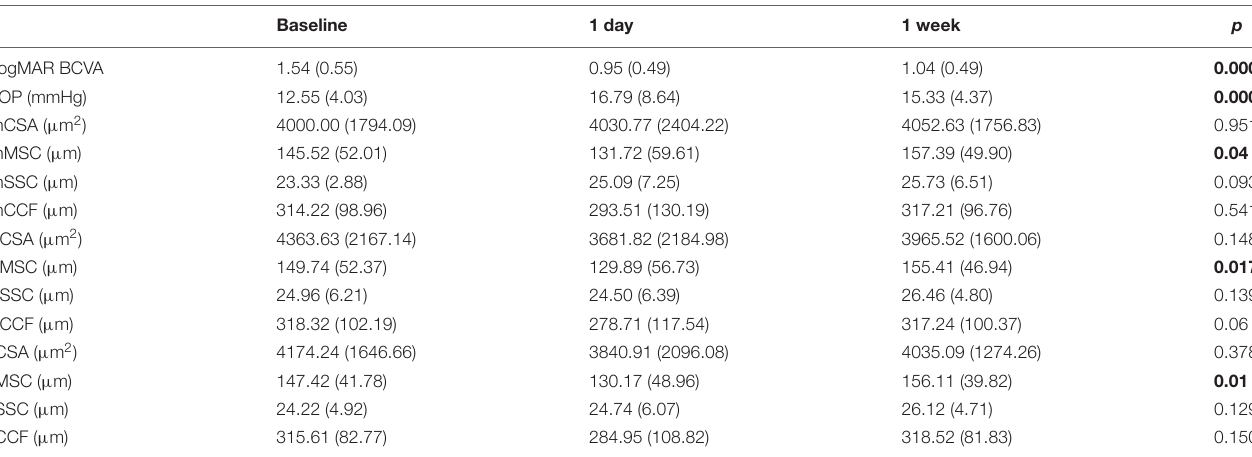
TABLE 2 | Comparisons between preoperative and postoperative parameters.